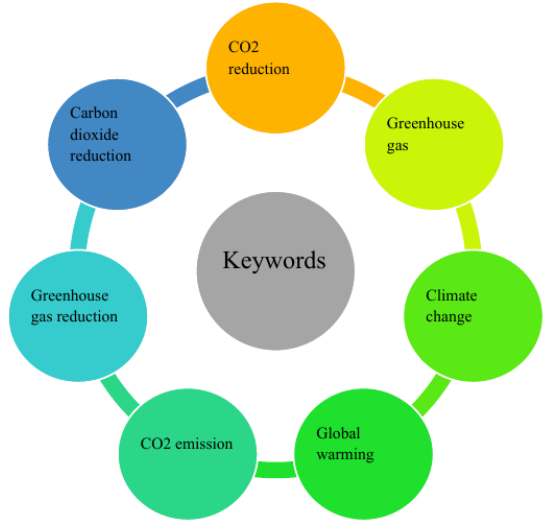
Figure 6. Related keywords for searching patents.